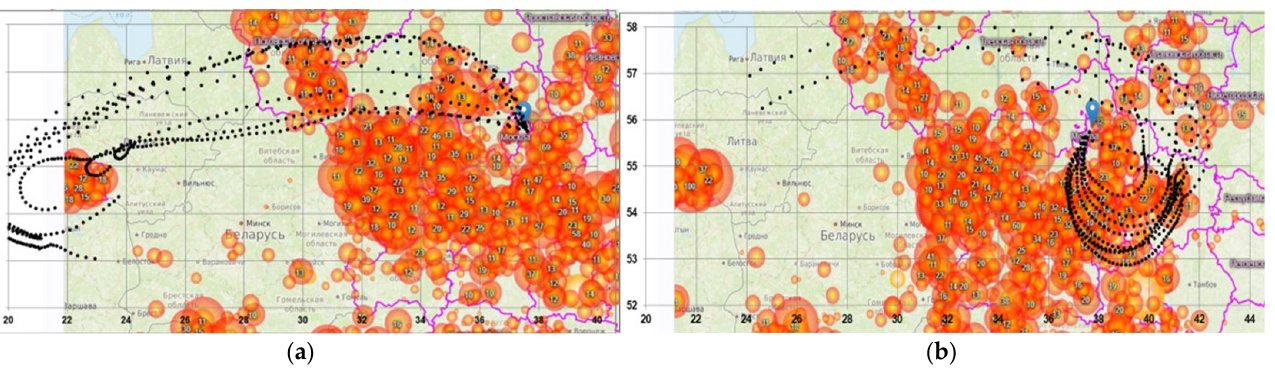
Figure 5. The dependence of the PM 10 aerosol concentration on the air pressure in the surface at- mosphere in Moscow during periods of intensive observations through the days outside the epi- sodes of maximum air pollution (Table 2): ( a ) spring 2020; ( b ) autumn 2020; ( c ) spring 2021. R 2 -the reliability coefficient of the linear relationship (straight lines) between variables.